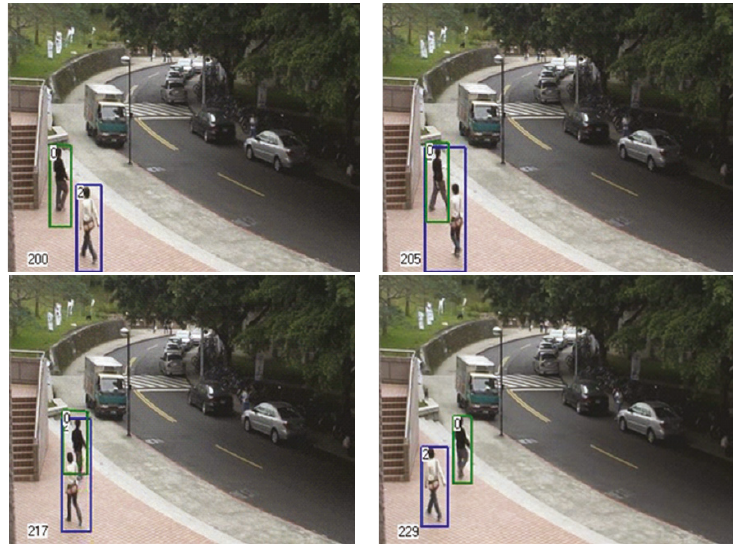
Figure 20: The results in human tracking—Environment